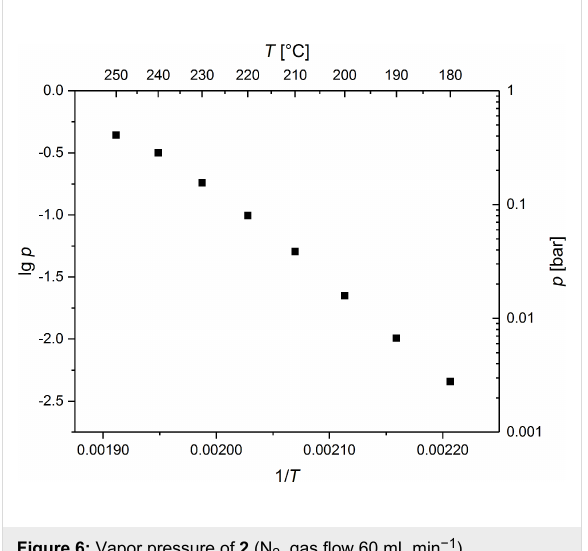
Figure 6: Vapor pressure of 2 (N 2 , gas flow 60 mL min − 1